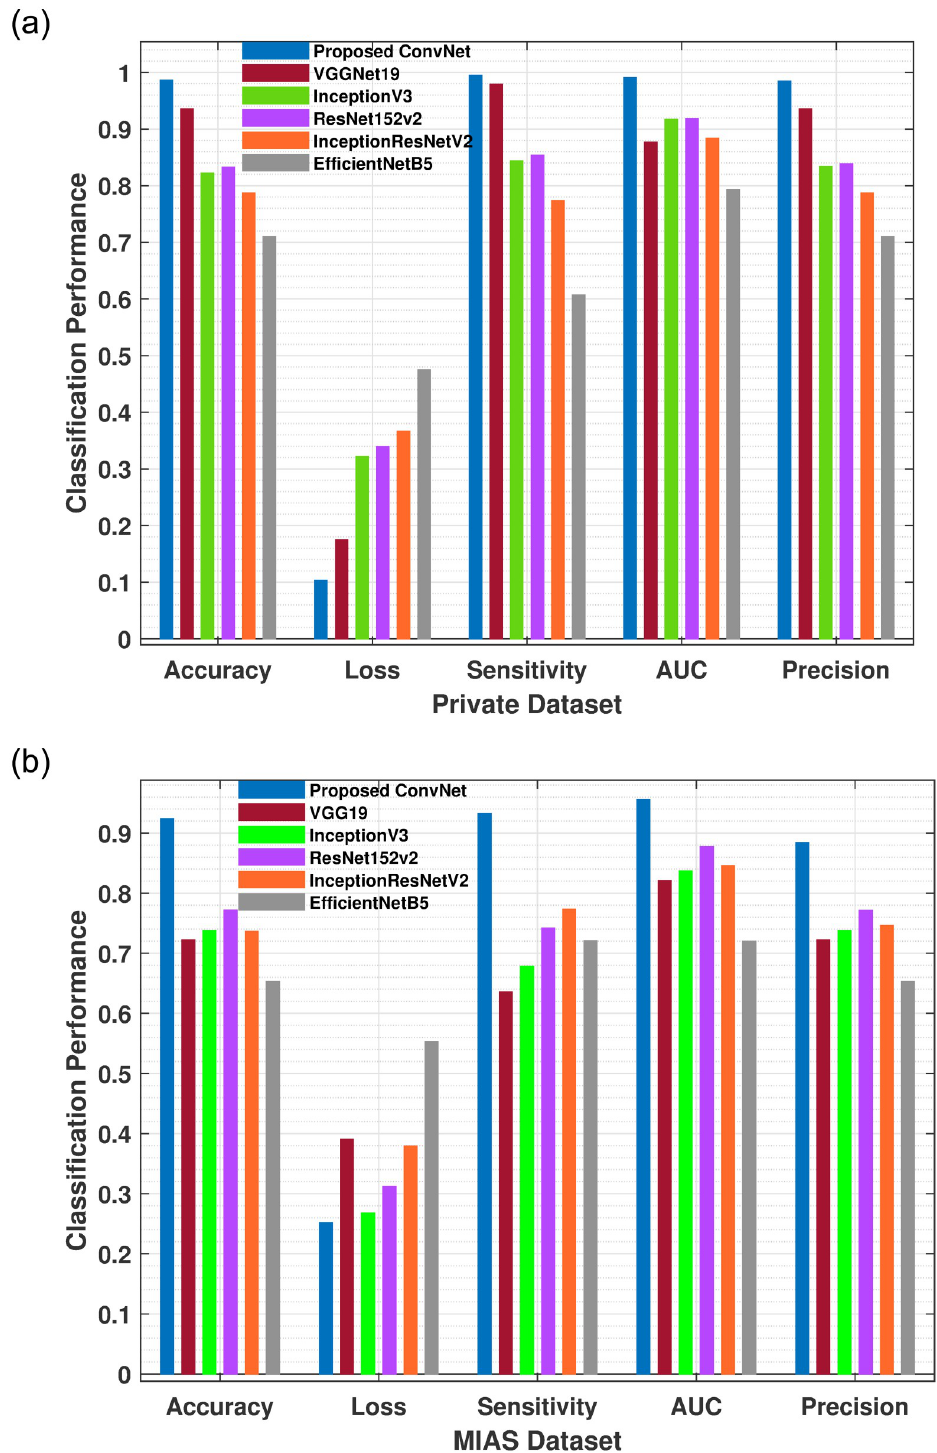
Fig 8. (a) The proposed architecture improves the average accuracy rate, AUC, precision, and sensitivity on Private dataset than MIAS dataset. The proposed model generates reduced false-negative results compared to existing DCNN models. (b) depicts the training accuracy, loss, sensitivity, AUC and precision of proposed ConvNet architecture and DCNN models on MIAS dataset. The proposed model shows promising performance compared to state-of-the-art standard